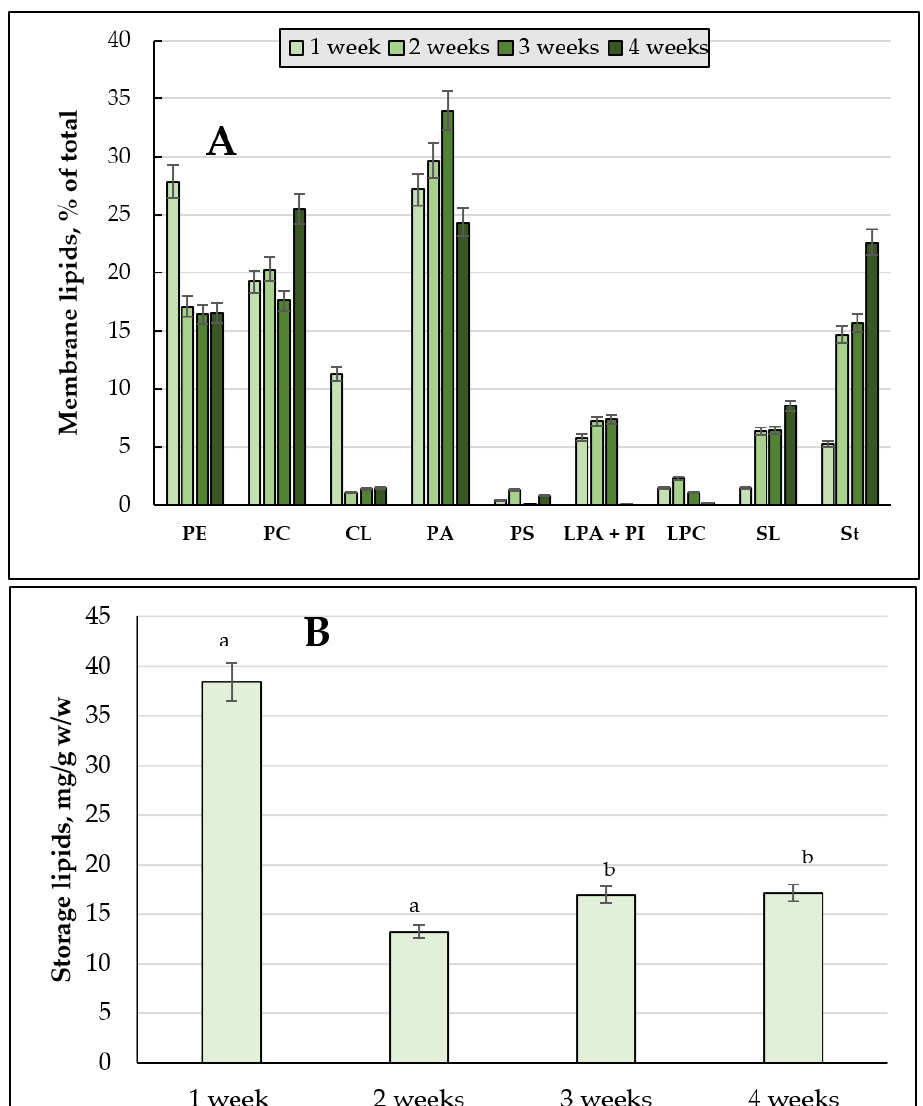
Figure 8. Membrane lipid composition of the mitochondria from E. magnusii cells raised in the different growth phases during long-lasting cultivation under 0.2% glucose utilization. ( A ) the share of each membrane lipid fraction; PE—phosphatidylethanolamines; PC—phosphatidylcholines;